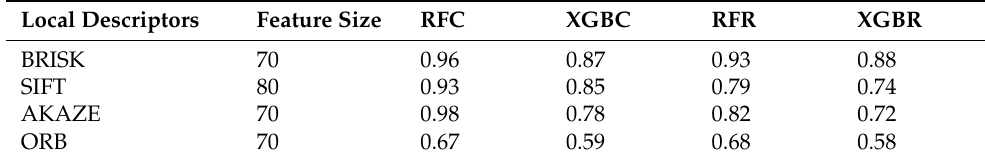
Table 3. F1-score over the local features with the BOWN